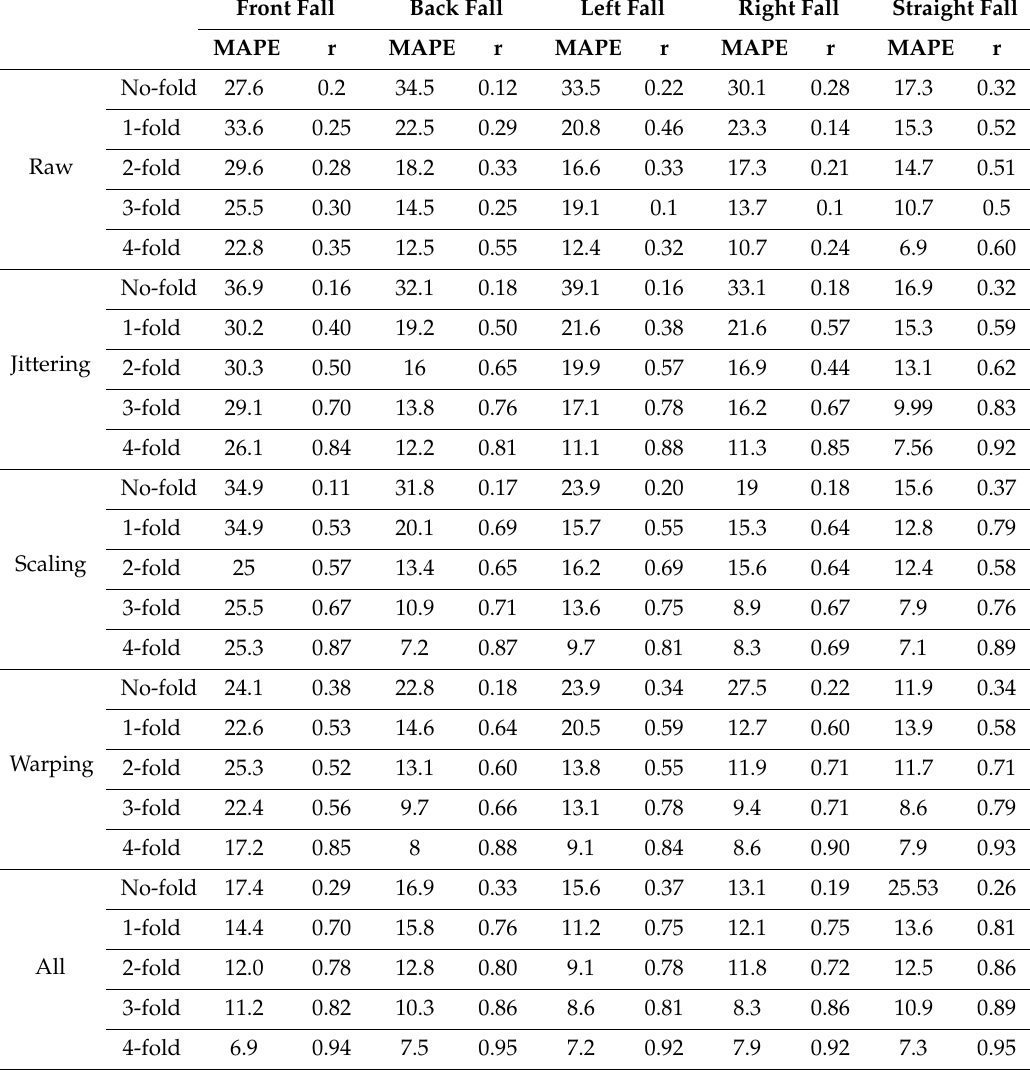
Table 3. Overall performance of our proposed fall impact acceleration prediction model (MAPE: mean absolute percent